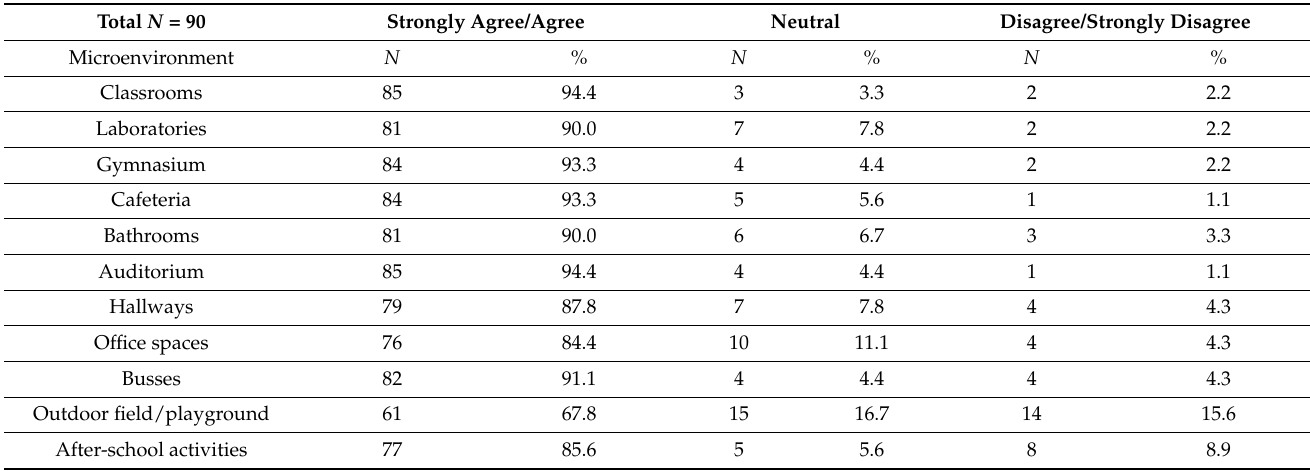
Table 4. Study participant level of agreement for each school setting with the following statement: “Social distancing policies are necessary in . . . [microenvironment listed] . . .